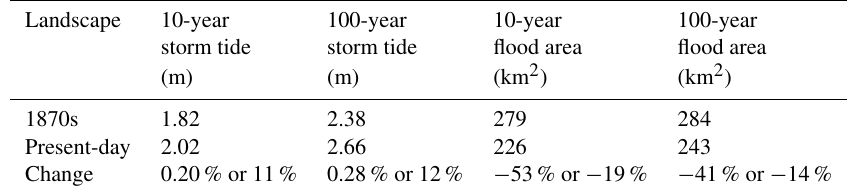
Table 2. Storm tide elevation and flood area for 1870s versus present-day landscapes ∗ .